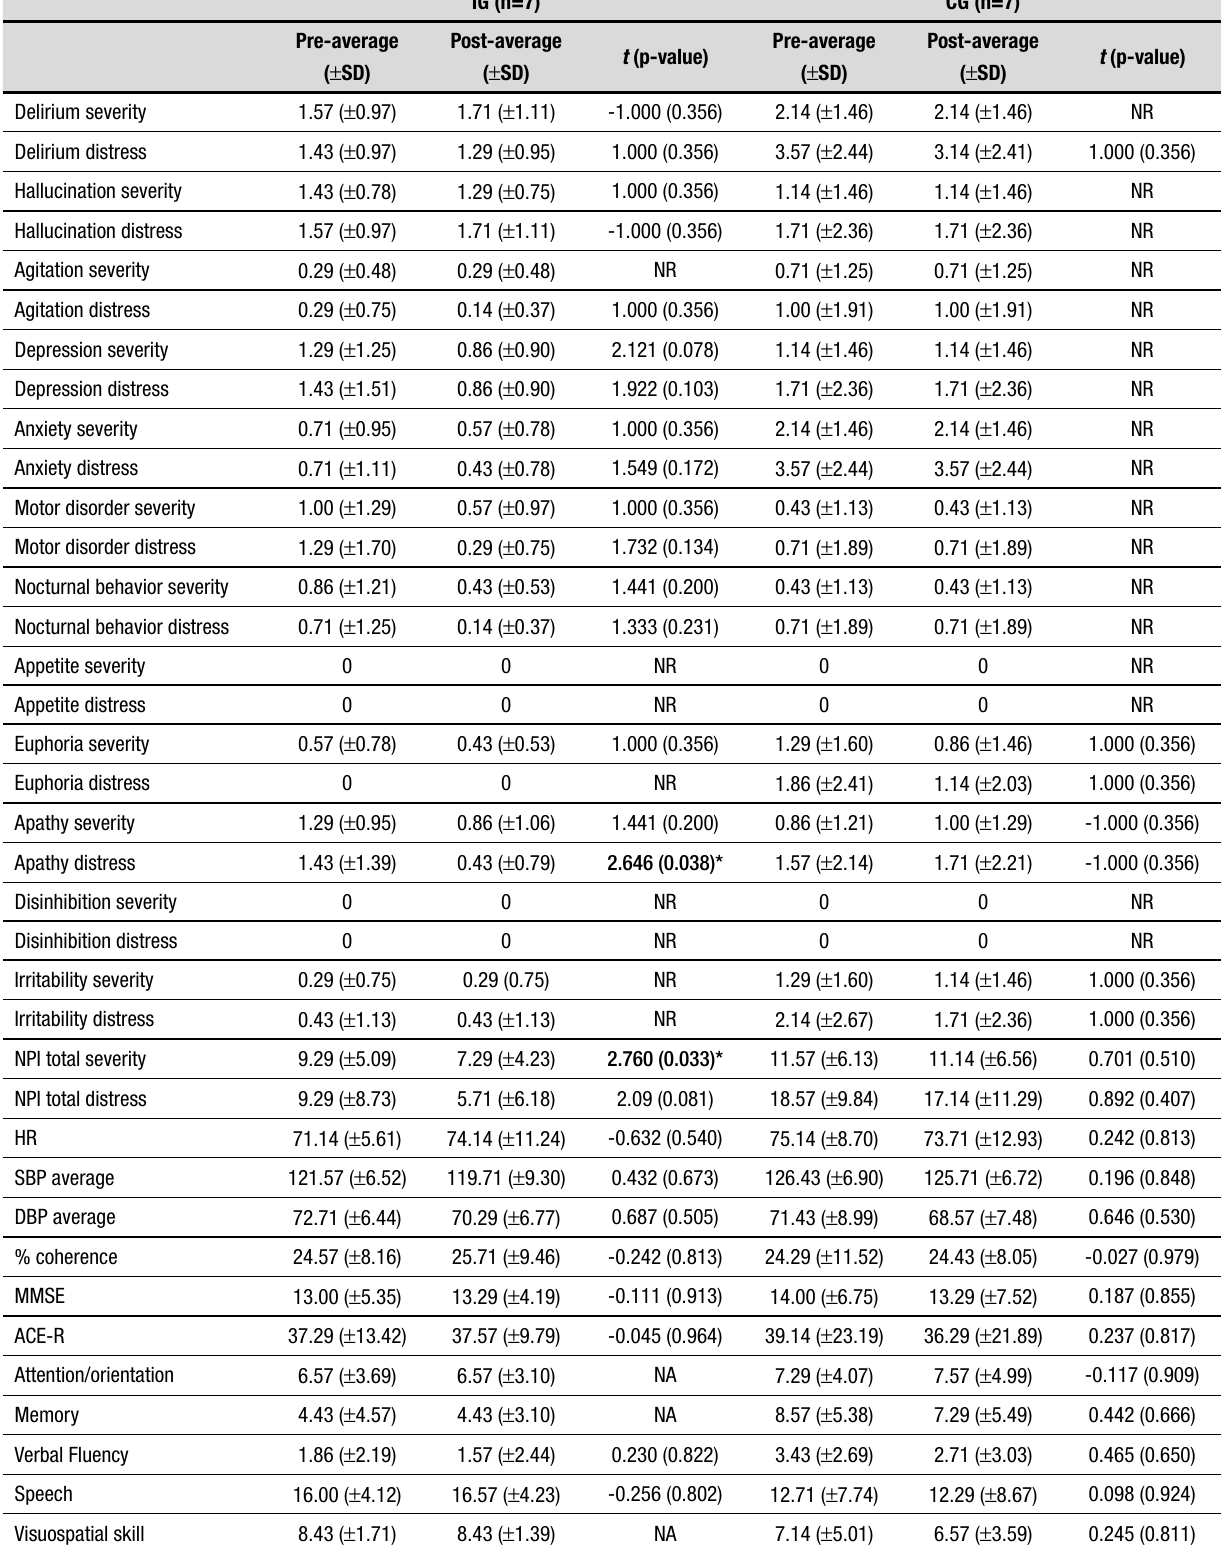
Table 2. Comparison of the pre- and post-intervention group (n=7) and the pre- and post-control group (n=7) for the outcome variables. São Carlos, SP,